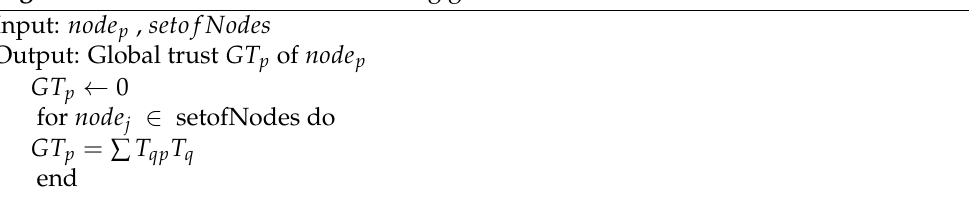
Algorithm 1 Pseudo-code for calculating global